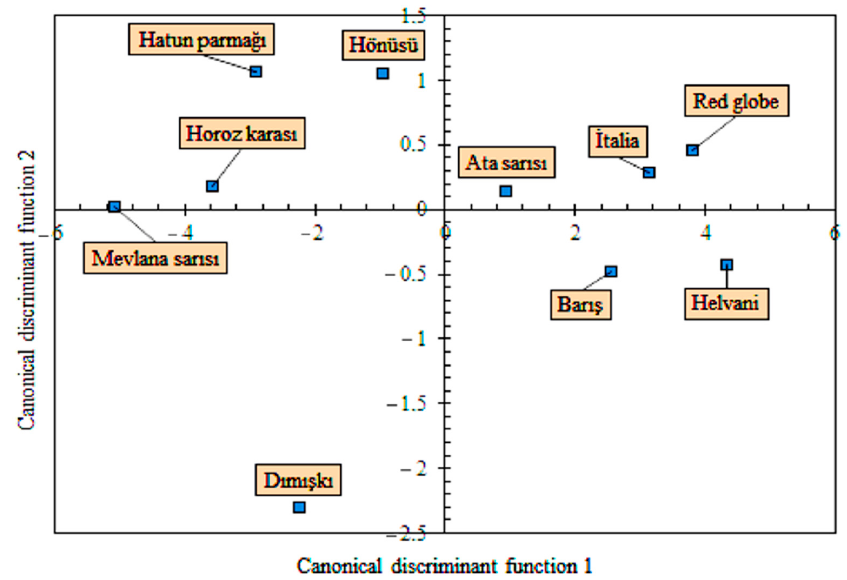
Figure 6. Biplot charts from linear discriminant analysis of 10 grape varieties, based on two principal components of shape variables, derived from elliptic Fourier data of 400 fruit outlines (the locations of the varieties on the chart show their own group centroid).